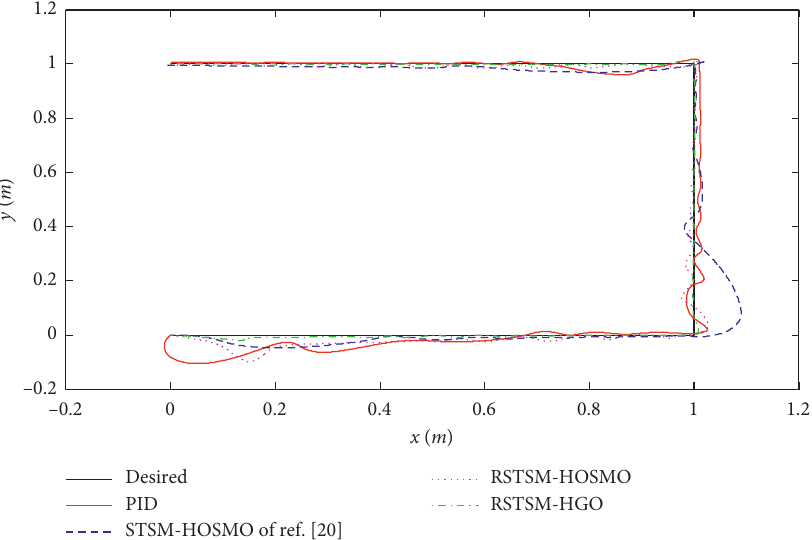
Figure 5: Anti-C-shaped reference trajectory tracking response diagram.